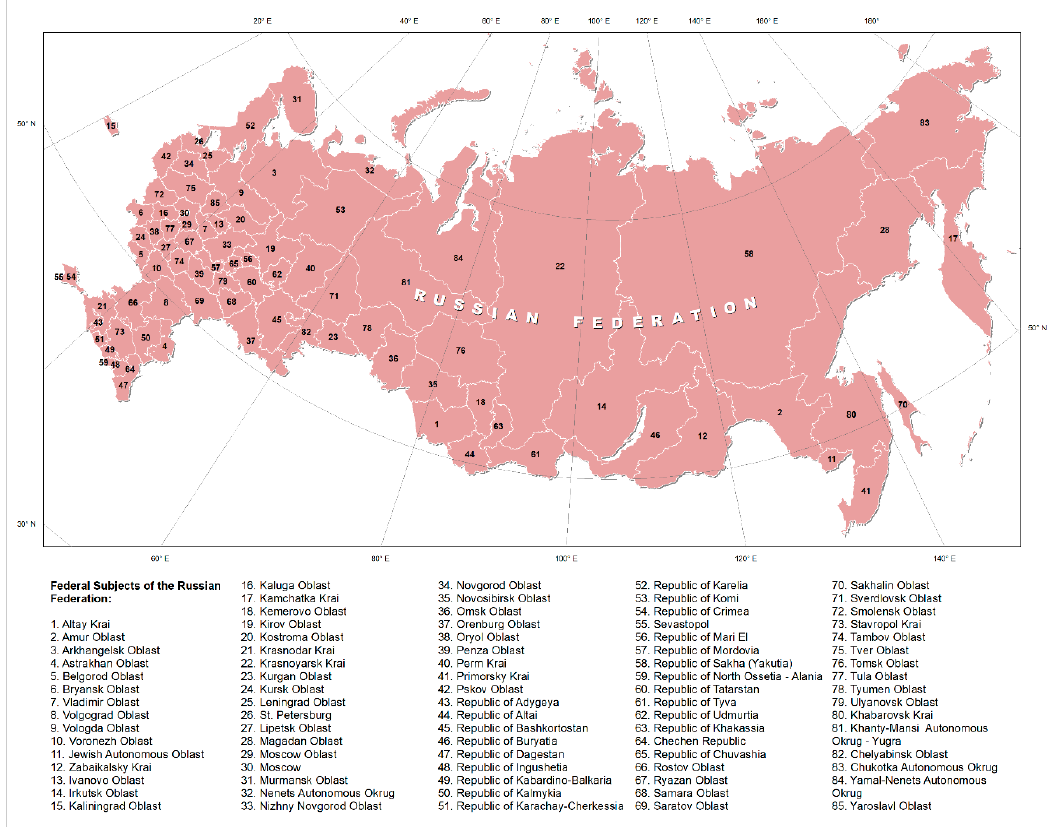
Figure 1. Administrative divisions of Russia.